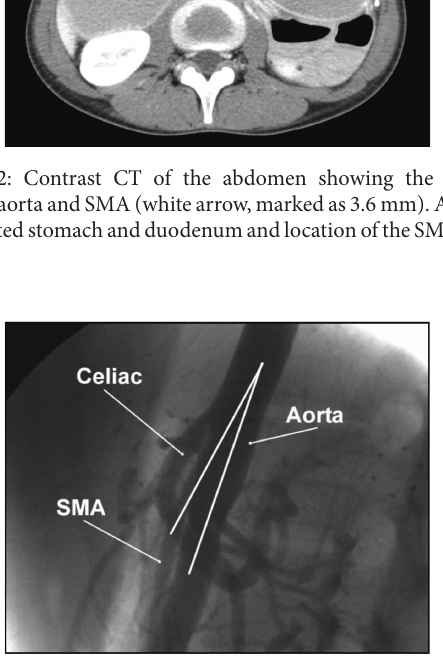
Figure 3: Angiography of the abdominal aorta. The celiac and SMA branches are identified, as well as a narrow-angle formed between the abdominal aorta and the SMA